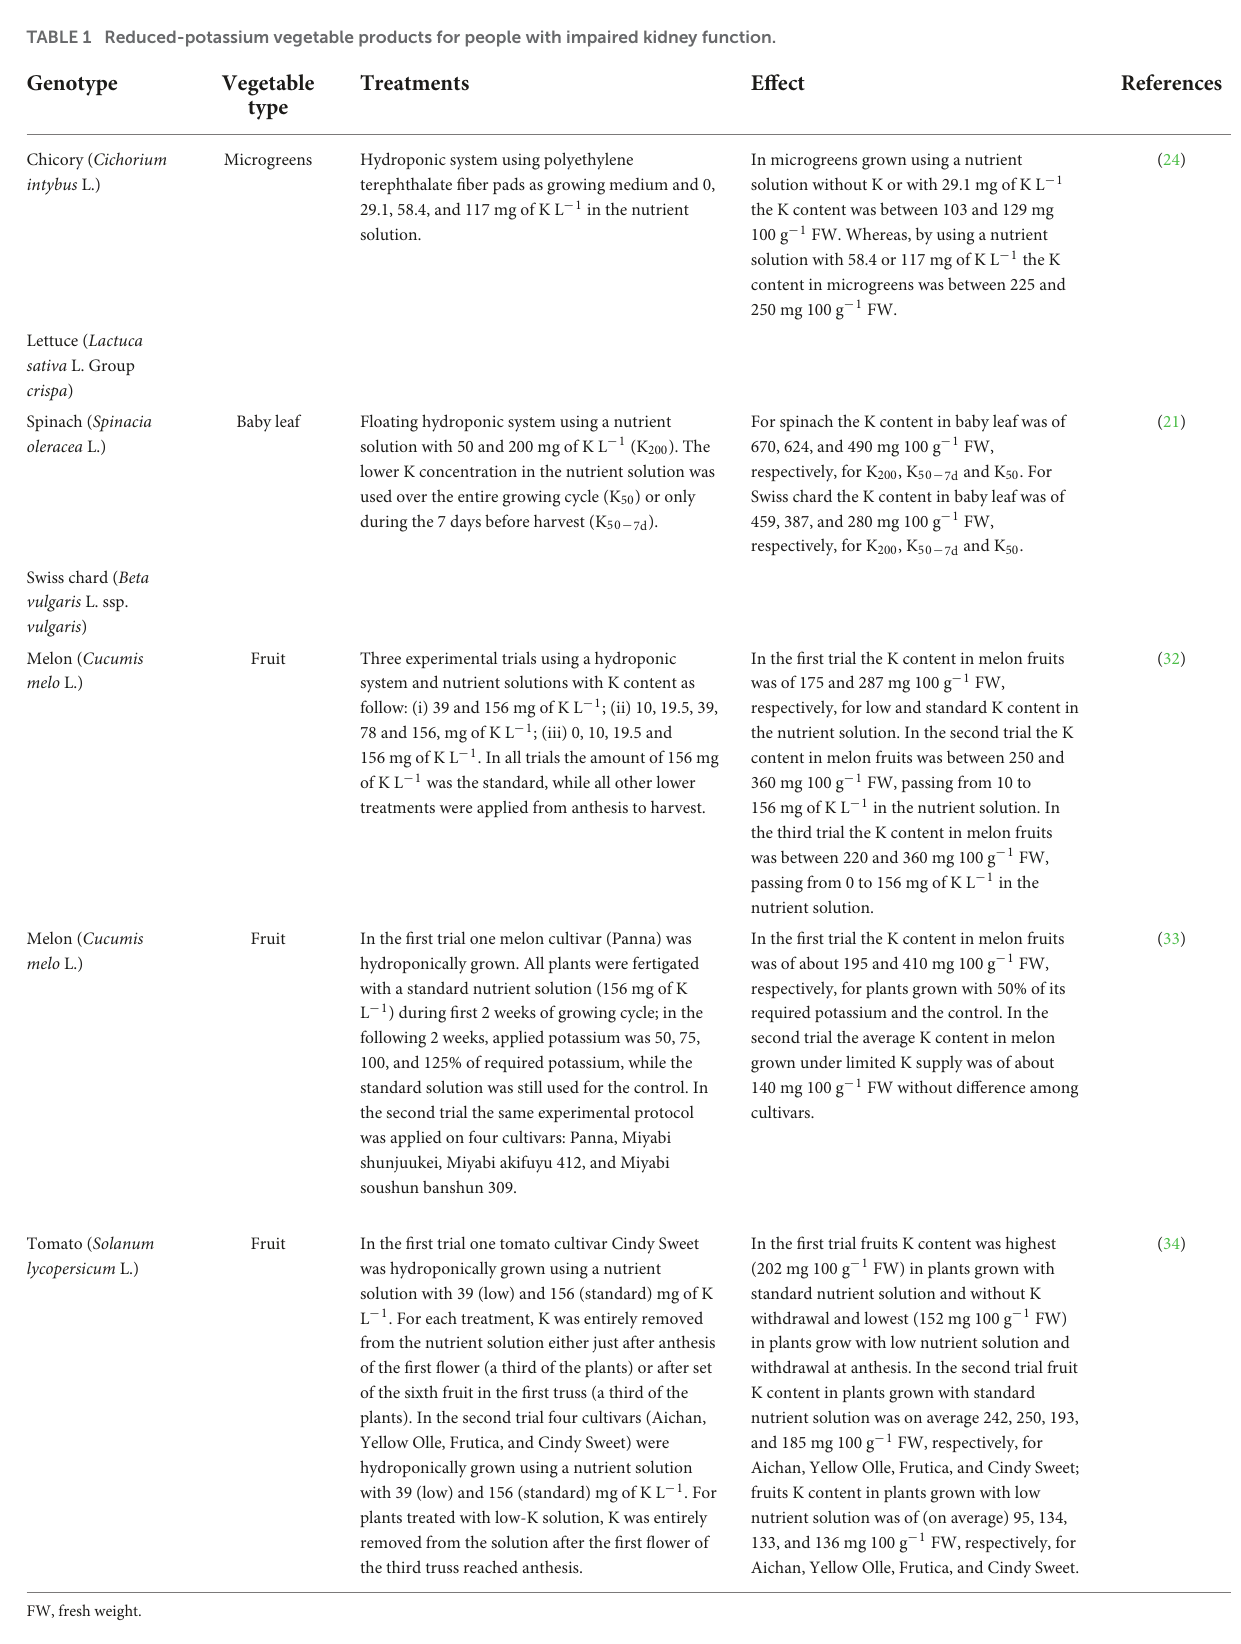
TABLE 1 Reduced-potassium vegetable products for people with impaired kidney